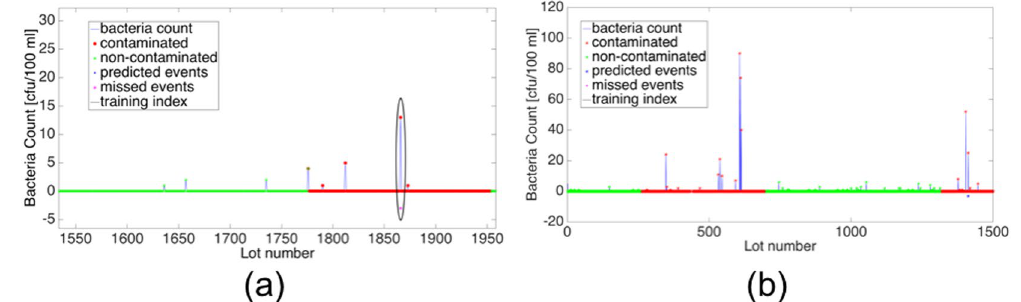
Figure 3. Rosh Hayin 5 SVM Analysis. ( a ) A snippet from Rosh Hayin 5 counts time series (April 1 st ,